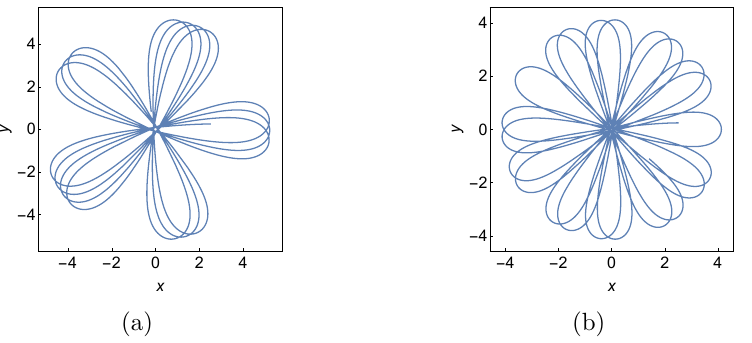
Figure 6 . We here show two examples of bound states for α 0 = 10 : (a) ω = 100 , a = 5 , b = 0 . 5 and t = 200 ; (b) ω = 200 , a = 5 , b = 0 . 5 and t f